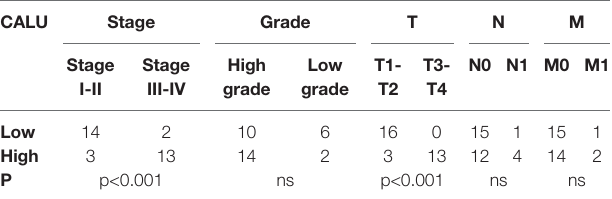
TABLE 4 | Clinical information of the recruited BLCA patients. CALU Stage Grade T N M